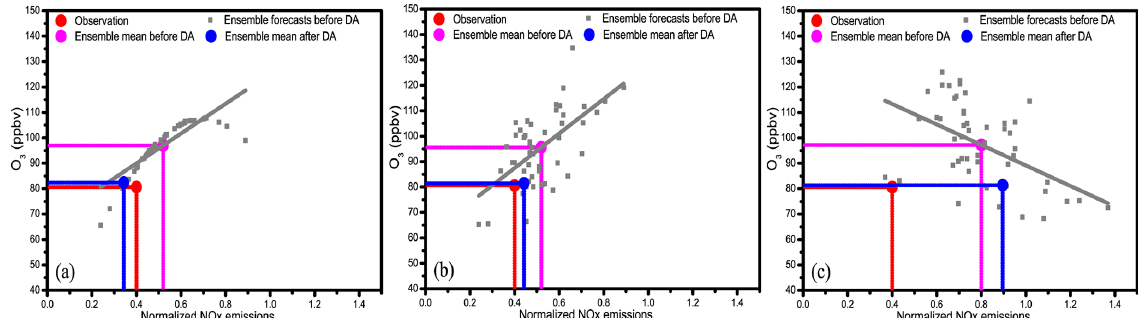
Figure 6. (a–c) O 3 concentrations (ppbv) and NO x emissions (no unit, normalized by the true NO x emission) before and after data assimi- lation and their ensemble samples before DA at 12:00LT on 12 August 2008 in the three ideal DA experiments. The NO 2 photolysis rate is assumed to be overestimated by 20%. (a) The prior NO x emission is overestimated by 30% and adjusted by the DA, but the uncertainty of the NO 2 photolysis rate is not included (there are no perturbations of the NO 2 photolysis rate) in the DA. (b) The same as the DA experiment in (a) , but the uncertainty of the NO 2 photolysis rate is taken into account by perturbing it. (c) The same as the DA experiment in (b) , but the bias in the prior NO x emission is increased to 100%. The magenta dot, the gray squares, the gray line, the red dot, and the blue dot represent the same information as in Fig.